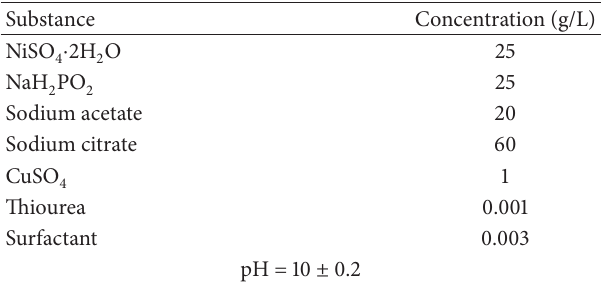
Table 1: Chemical composition of electroless plating